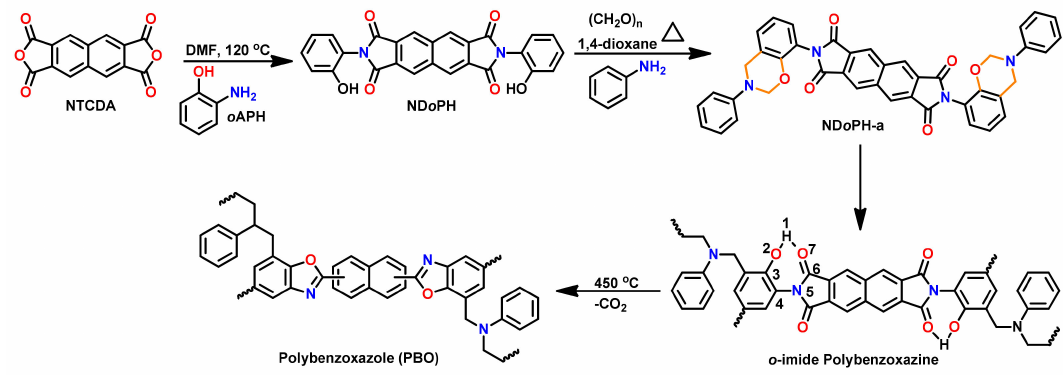
Figure 29. Direct synthesis of o-imide benzoxazine monomer followed by polymerization [244].